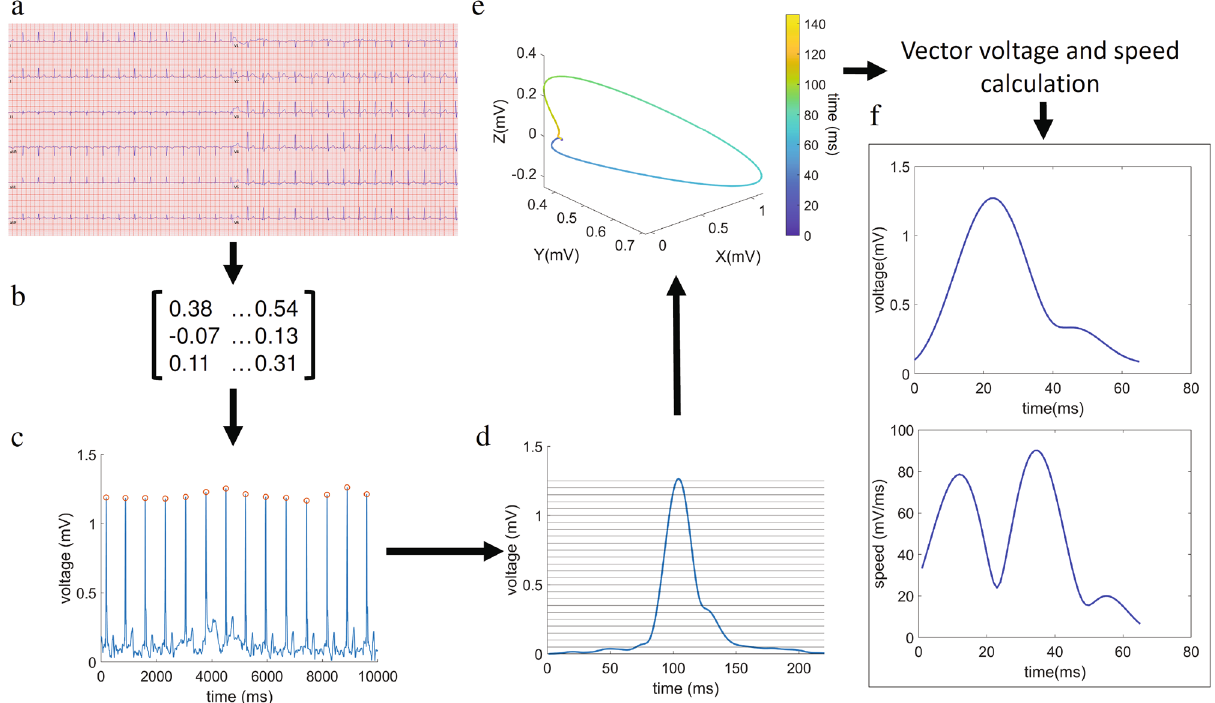
Figure 6. ECG-derived VCG extraction algorithm and calculation of instantaneous vector voltage and speed kinetics. ( a ) Raw ECG data is loaded into the program as input. ( b ) Kors transformation matrix is applied to the raw data. ( c ) Peaks are identified along the voltage (spatial vector magnitude) over time signal. ( d ) Patient mean depolarization signal (peak-aligned) limits are identified by a custom adaptive threshold method. ( e ) VCG extraction (colour bar representing time in ms). ( f ) Instantaneous voltage and speed signals over time are obtained. The figure was created using MATLAB R2019b (https:// www. mathw orks.